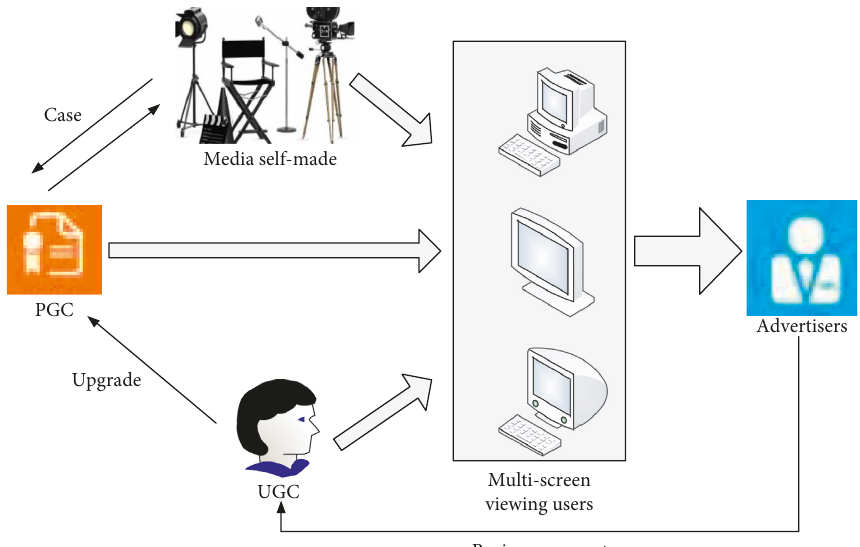
Figure 2: UGC user content